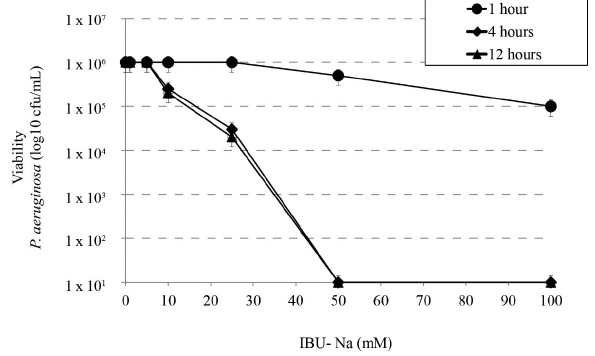
3 Figure 2. Effect of incubation time on bactericidal activity of IBU. Bactericidal effect of IBU-Na between 1 to 100 mM concentration at different incubation times (1, 4 and 12 h) on P. aeruginosa inoculum (1 × 10 6 cfu/mL).